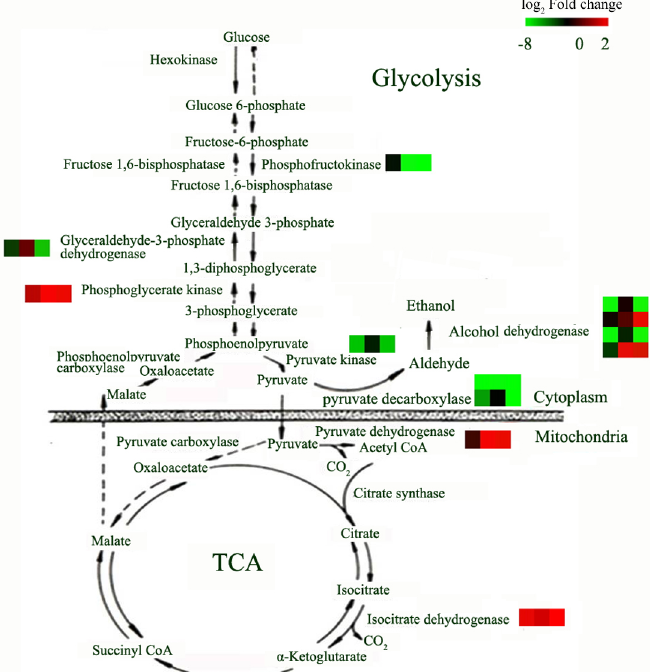
Fig 7. Genes involved in glycolysis and the TCA cycle that displayed altered expression in sugarcane under low-K stress. The relative expression levels at 8 h, 24 h and 72 h are shown adjacent to a color gradient from low (green) to high (red). The probes for the differentially expressed genes were CUST_47734 (phosphofructokinase), CUST_11240 (glyceraldehydes-3-phosphate dehydrogenase), CUST_48571 (phosphoglycerate kinase), CUST_6383 (pyruvate kinase), CUST_15254, CUST_44992 (pyruvate decarboxylase), CUST_5247, CUST_7632, CUST_2997, CUST_45329 (alcohol dehydrogenase), CUST_25413 (pyruvate dehydrogenase), and CUST_53982 (isocitrate dehydrogenase).